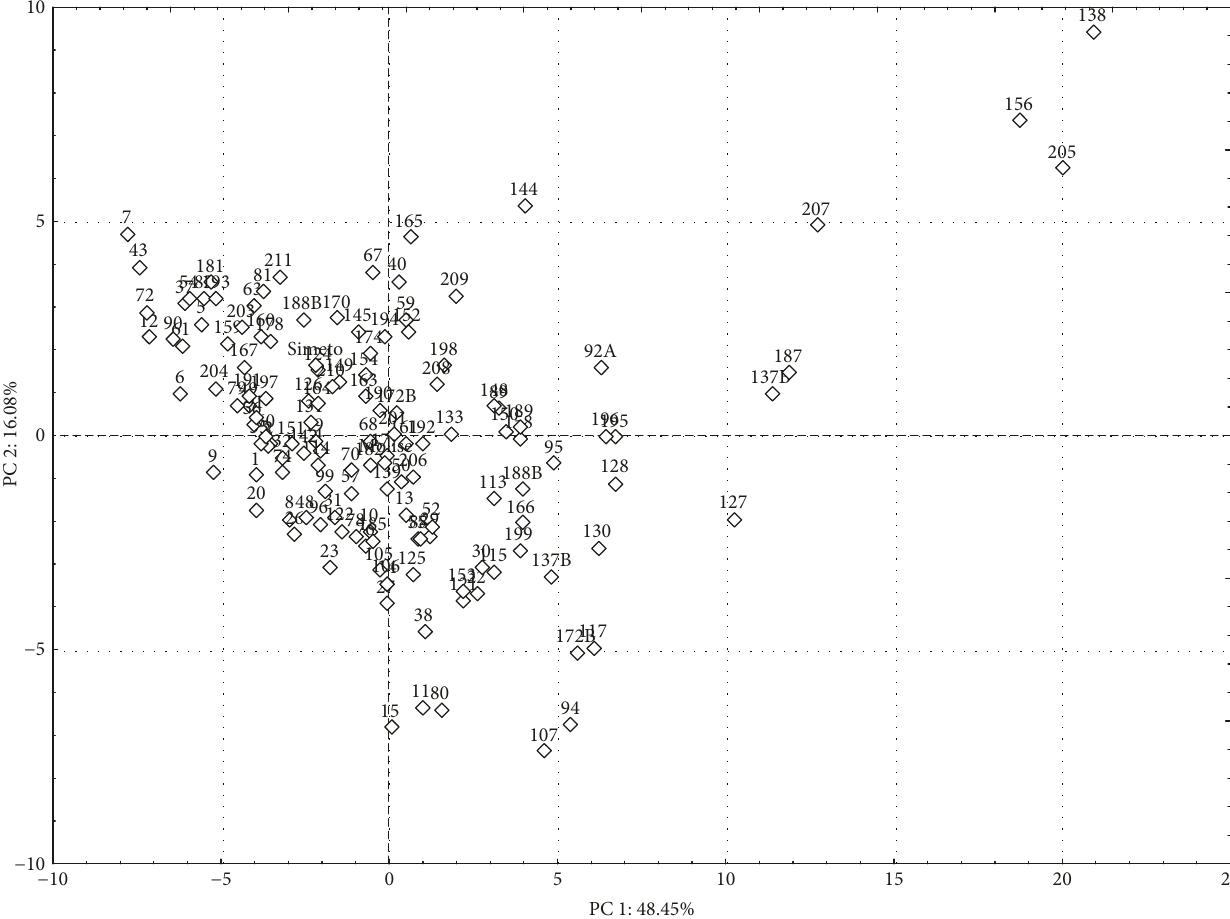
Figure 1: Principal component analysis score plot of the fi rst two principal components of the parental lines and RILs from the durum wheat “ Simeto ” × “ Molise Colli ” population for the root